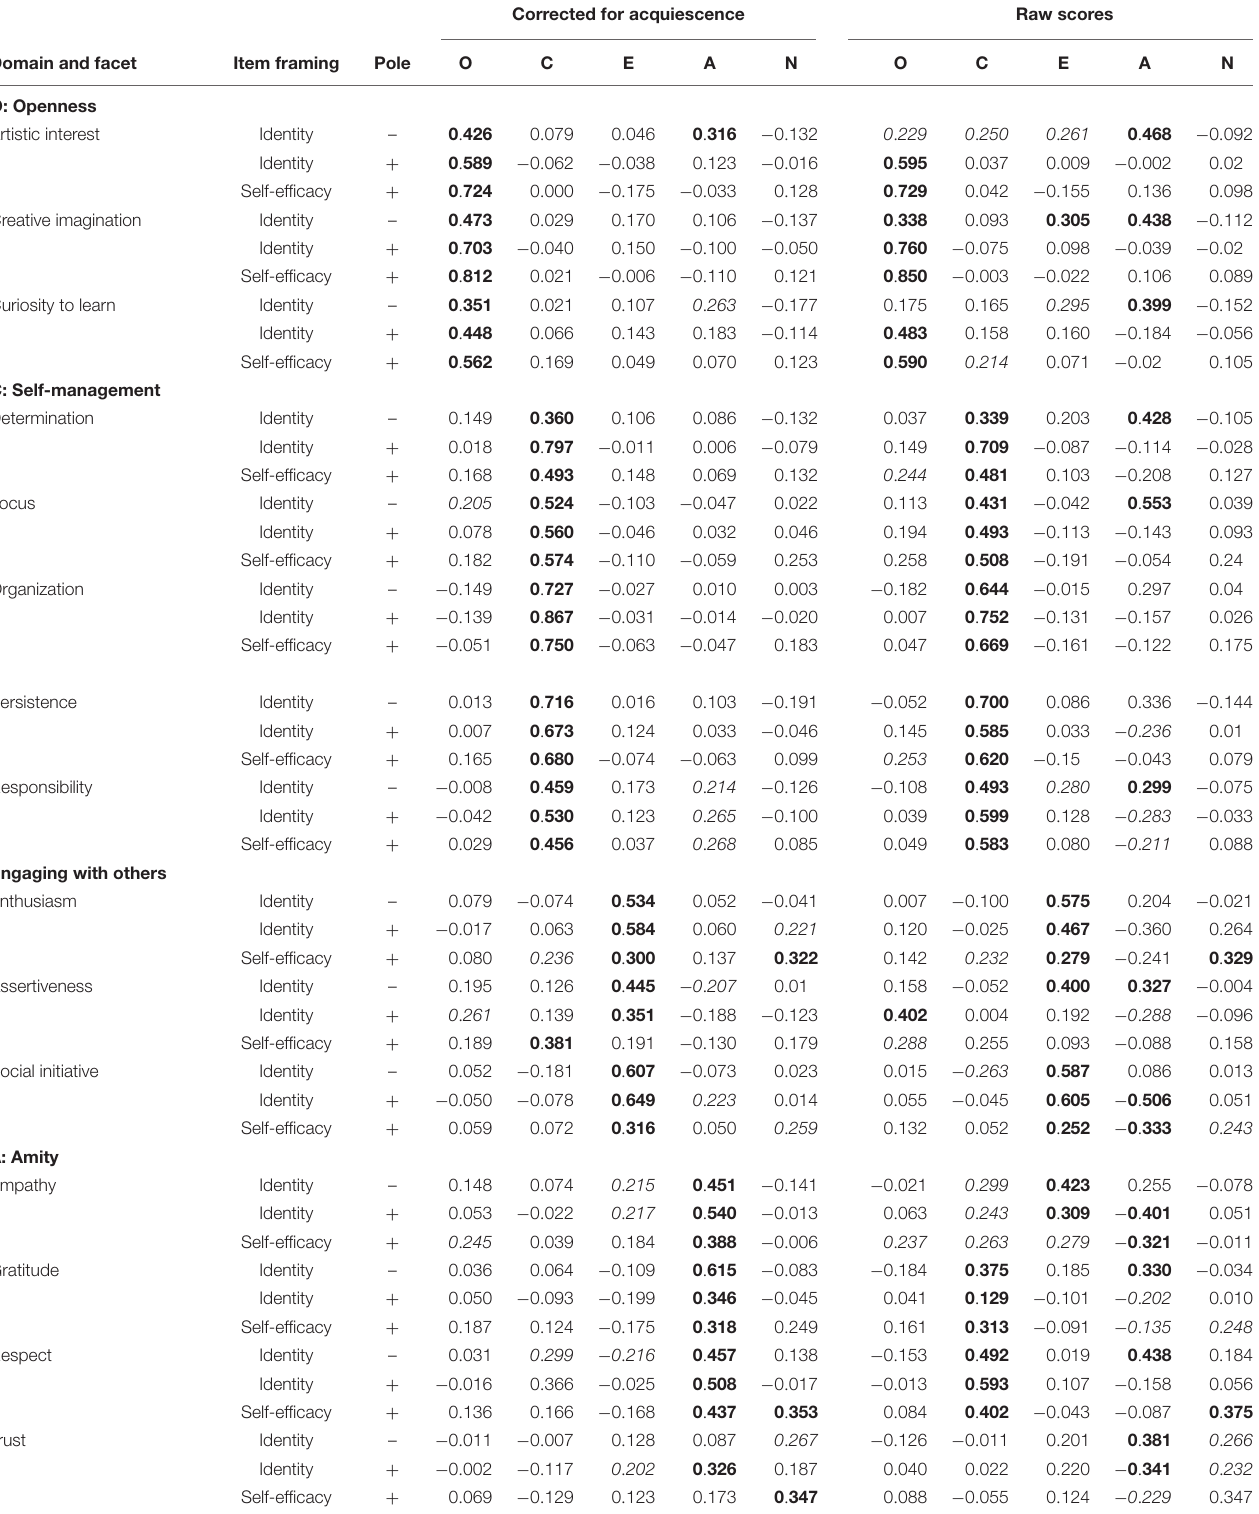
TABLE 3 | Factor loadings of Exploratory Structural Equation Modeling (ESEM) of 54 SEMS indicators, measured with either positively keyed or negatively keyed trait-identity items or self-efficacy items. Corrected for acquiescence Raw